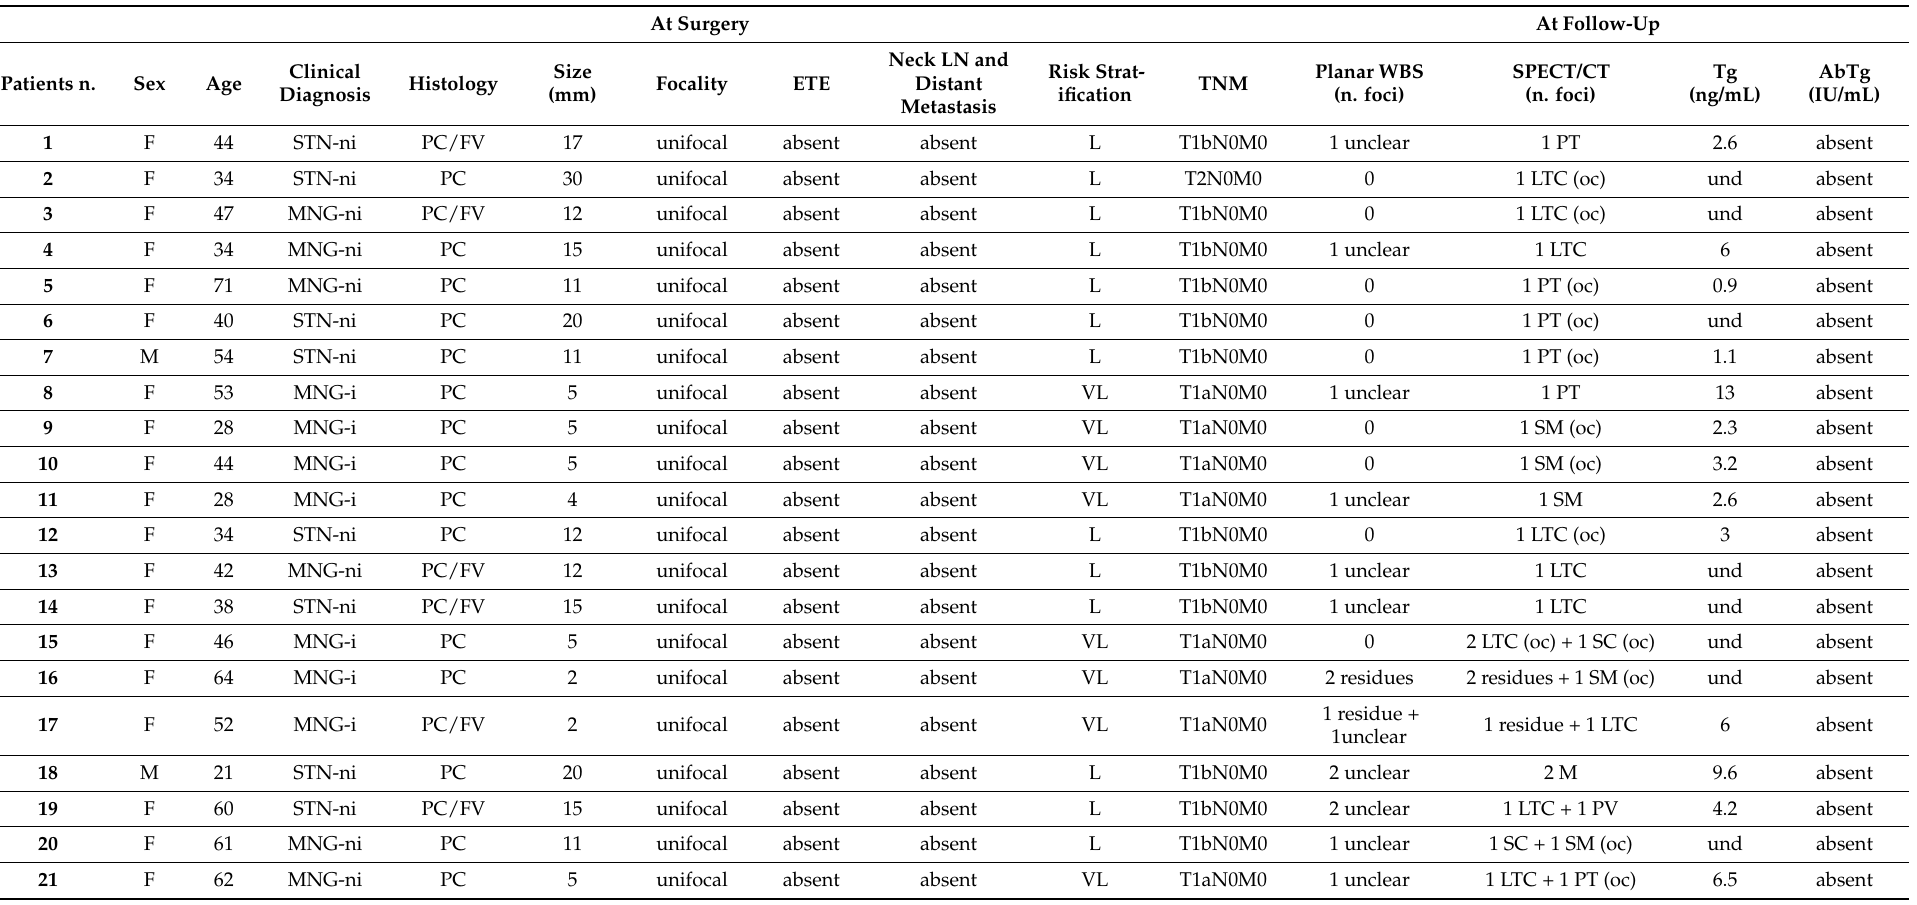
Table 3. Clinical-pathological data of 21/312 patients with PC without GD at the surgery of the primary tumor and at long-term follow-up. All these patients without risk factors at surgery developed metastases after thyroidectomy and radioiodine ablation. At Surgery At